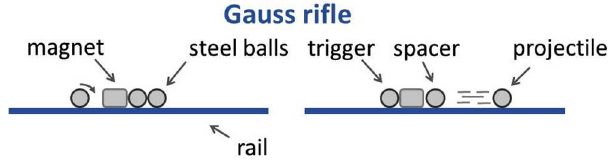
Fig. 1. Sketch depicting a Gauss rifle.